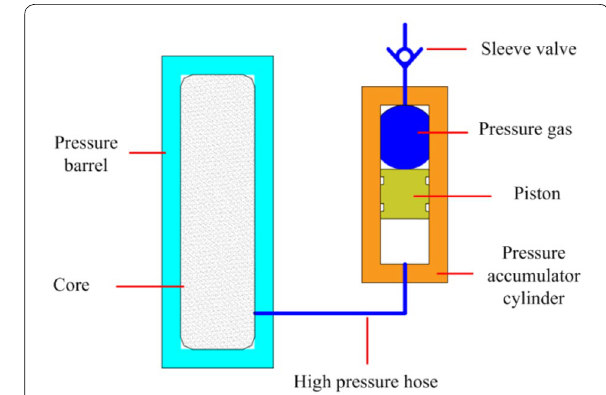
Figure 10 Schematic of passive pressure-retaining technique with external accumulator (PPRT)